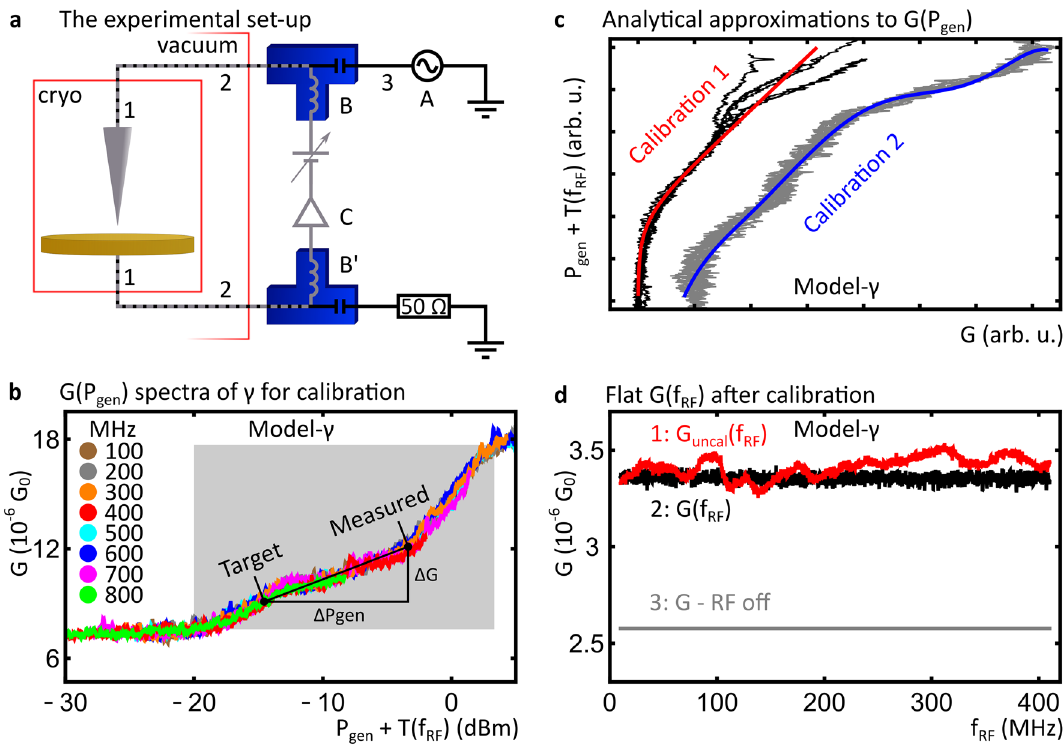
Figure 4. Details of the set-up and calibration ( a ) A schematic of the RF-STM set-up. ( b ) G ( P gen ) spectra obtained on model-γ ( V DC -550 mV) for eight different f RF values. Spectra are shifted horizontally to account = for differences in T ( f RF ) . ( c ) Inverted G ( P gen ) spectra obtained on model-γ ( V DC -550 mV for the black and grey spectra, respectively) and their respective analytical approximation, used for f RF calibration 1 and 2. ( d ) G spectra with RF modulation on, uncalibrated (1) and calibrated (2), obtained on (cid:30) (cid:31) model-γ with constant V DC -530 mV. The nominal value of G in absence of RF modulation is also indicated =